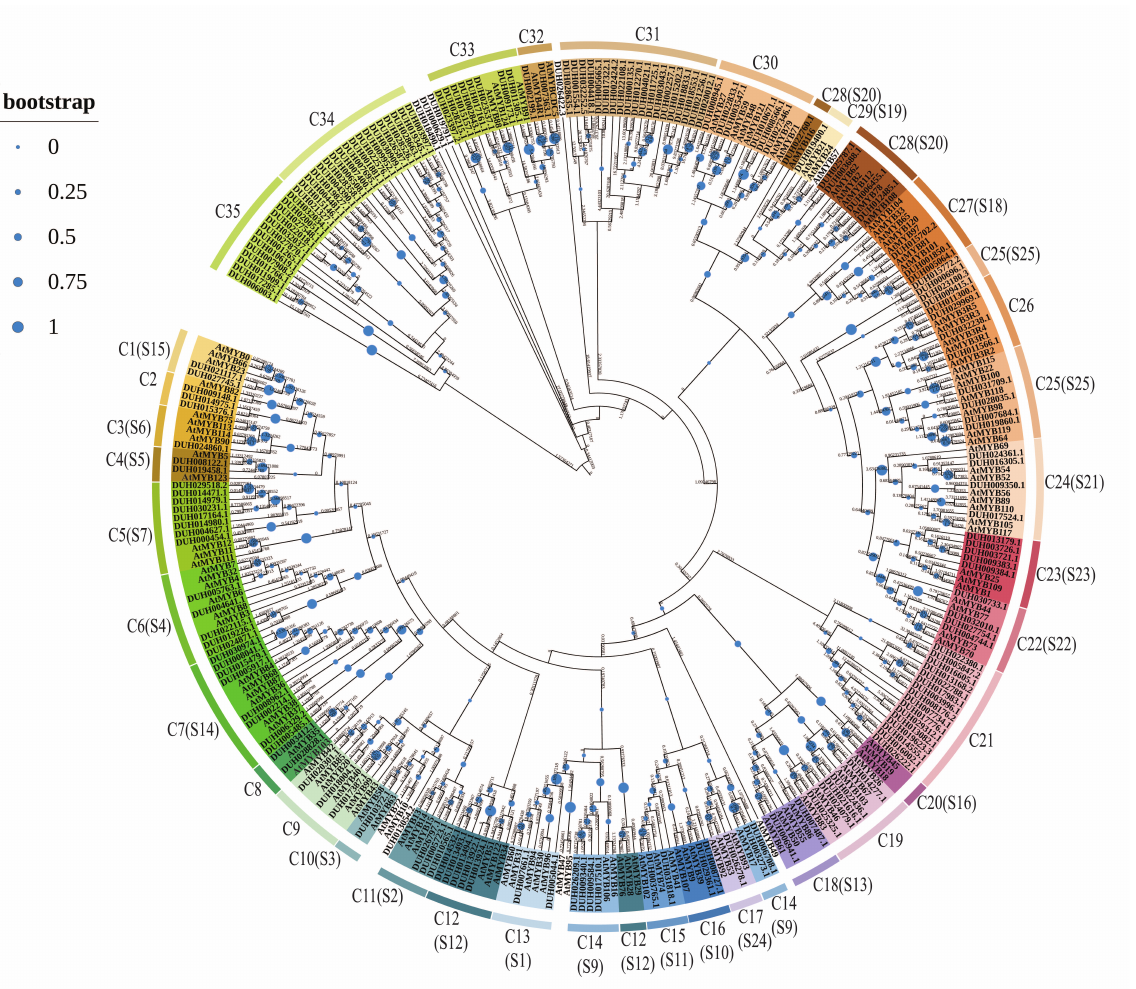
Figure 4. Phylogenetic tree of MYB proteins between Arabidopsis thaliana and Rhododendron delavayi (S). ML phylogeny was determined by MEGA7.0. Phylogenetic tree was divided into 35 main groups. Different colored clusters are labeled outside the tree, whereas their subgroups are marked with the corresponding color backgrounds. The blue circles on the branches are bootstrap and the numbers are branch